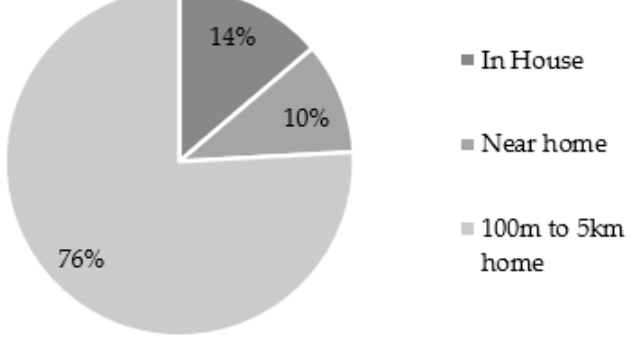
Figure 4. Distance from the place of death to the home of the inhabitants-June 2017 [16].